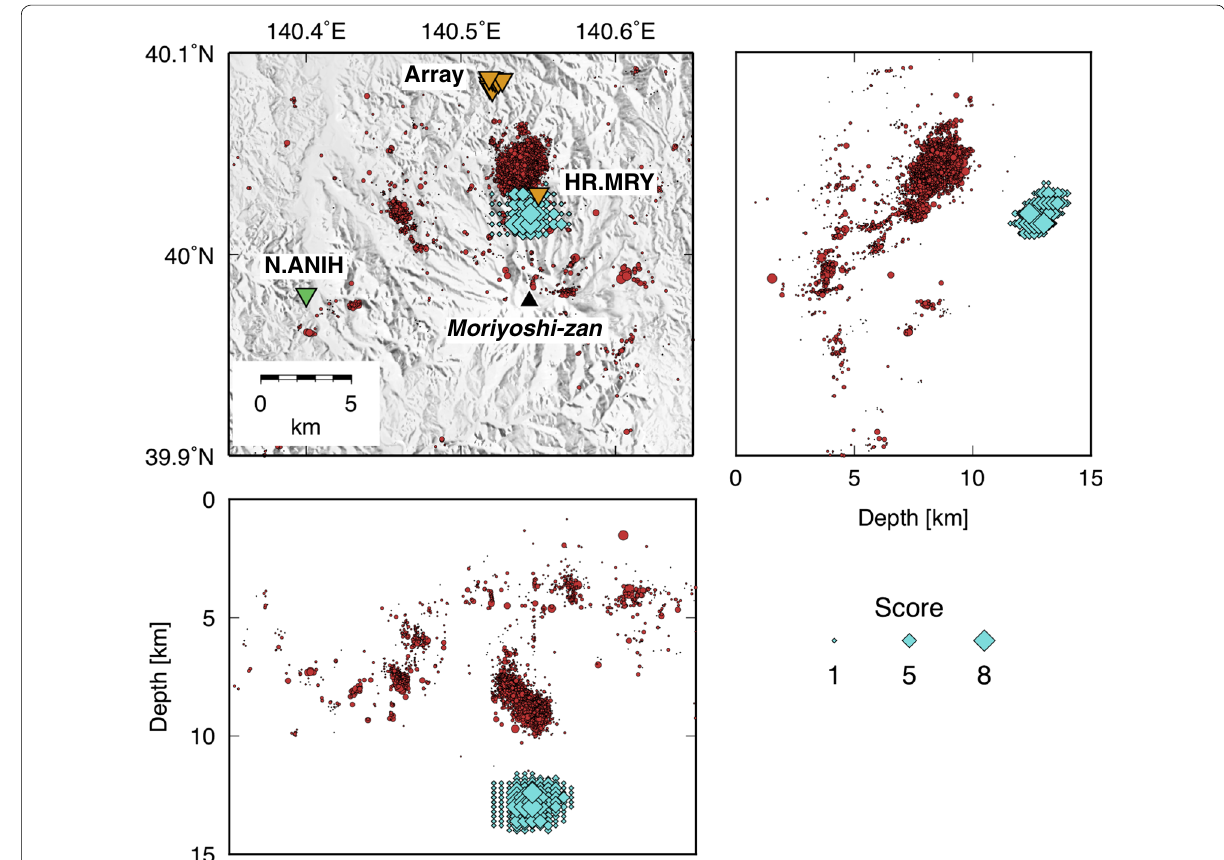
Fig. 9 Location of the DSW origin. Blue diamonds denote the accumulated scores given to hypothetical scattering points with the allowable difference between the observed and calculated incident azimuth, incident angle, and travel times. The size of the symbol is proportional to the score. The red circles denote hypocenters. Green and orange inverted triangles are Hi-net and temporary stations,